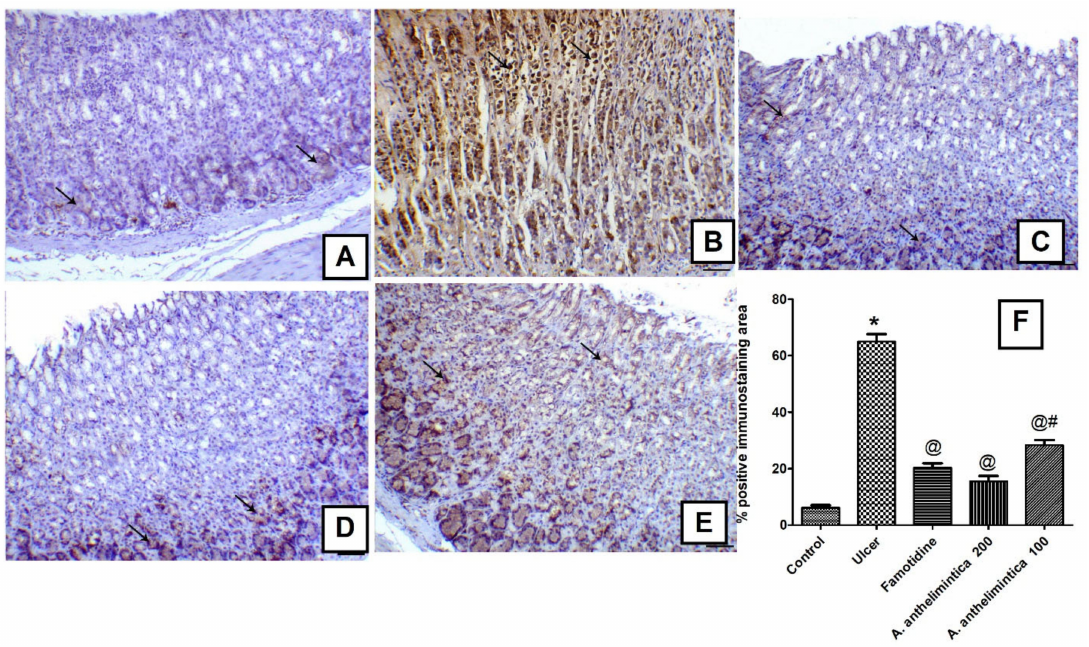
Figure 8. Effects of indomethacin alone and with oral pre-treatments of famotidine or A. anthelmintica (200, 100 mg/kg) on gastric inducible nitric oxide expression (iNOS) in rats. ( A ) Gastric mucosa of the control group showing scanty immunoexpression of iNOS within the basal parts of the gastric glands (arrows), ( B ) gastric mucosa of the ulcer group showing marked expression of iNOS within the degenerated gastric glands (arrows), ( C ) gastric mucosa of famotidine group showing marked decrease the expression of iNOS within the gastric glands (arrows), ( D ) gastric mucosa of A. anthelmintica (200 mg/kg) group showing marked decrease in the expression of iNOS within the gastric glands (arrows indicate expression within the basal parts of the glands), ( E ) gastric mucosa of A. anthelmintica (100 mg/kg) group showing a decrease in the expression of iNOS within the gastric glands (arrows), iNOS antibody, bar = 100 µ m. ( F ) Representative bar graph of the percentage of immunopositive area. Statistical analyses were carried out by one-way ANOVA followed by Tukey’s post hoc test, mean ± SEM. * Significantly different from control group at p < 0.05. @ Significantly different from indomethacin (ulcer) group at p < 0.05. # Significantly different from A. anthelmintica (200 mg/kg) group at p <